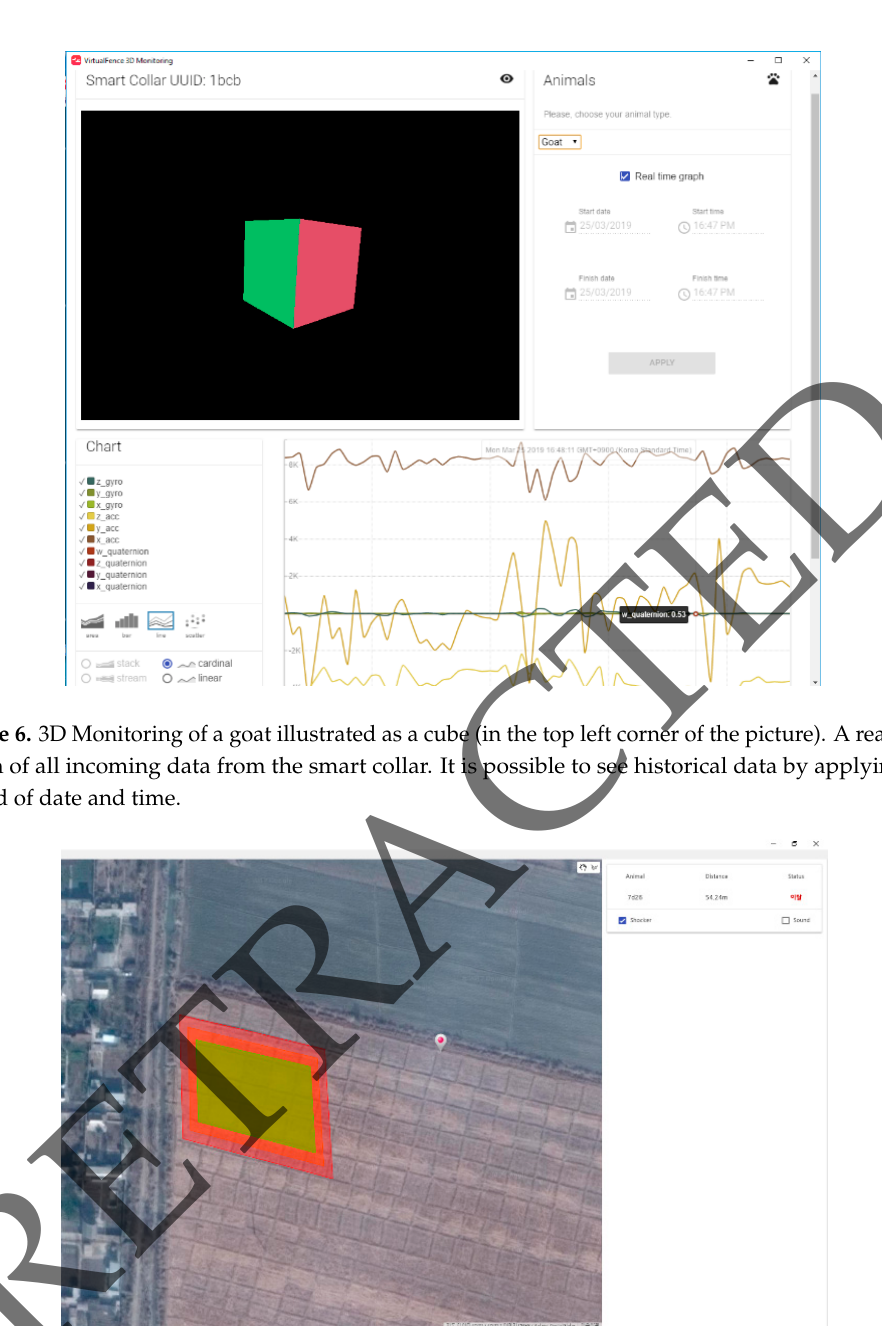
Figure 5. Virtual Fence settings GUI.